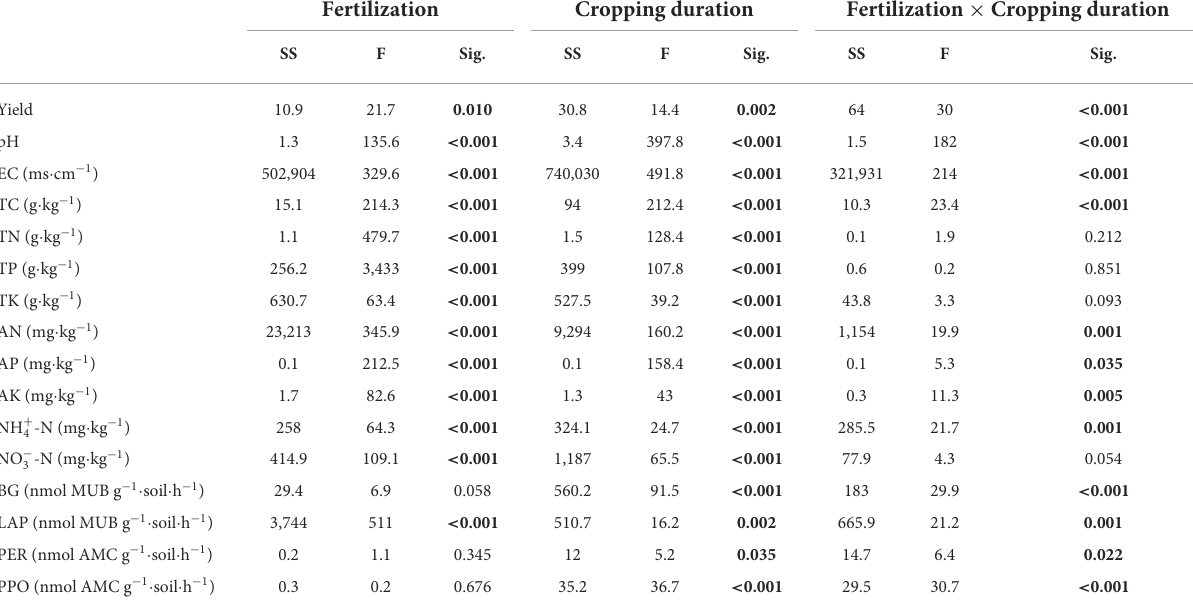
TABLE 1 Mixed effect ANOVA for the effects of fertilization, crops, and their interaction on soil properties. Fertilization Cropping duration Fertilization × Cropping duration SS F Sig. SS F Sig. SS F Sig.